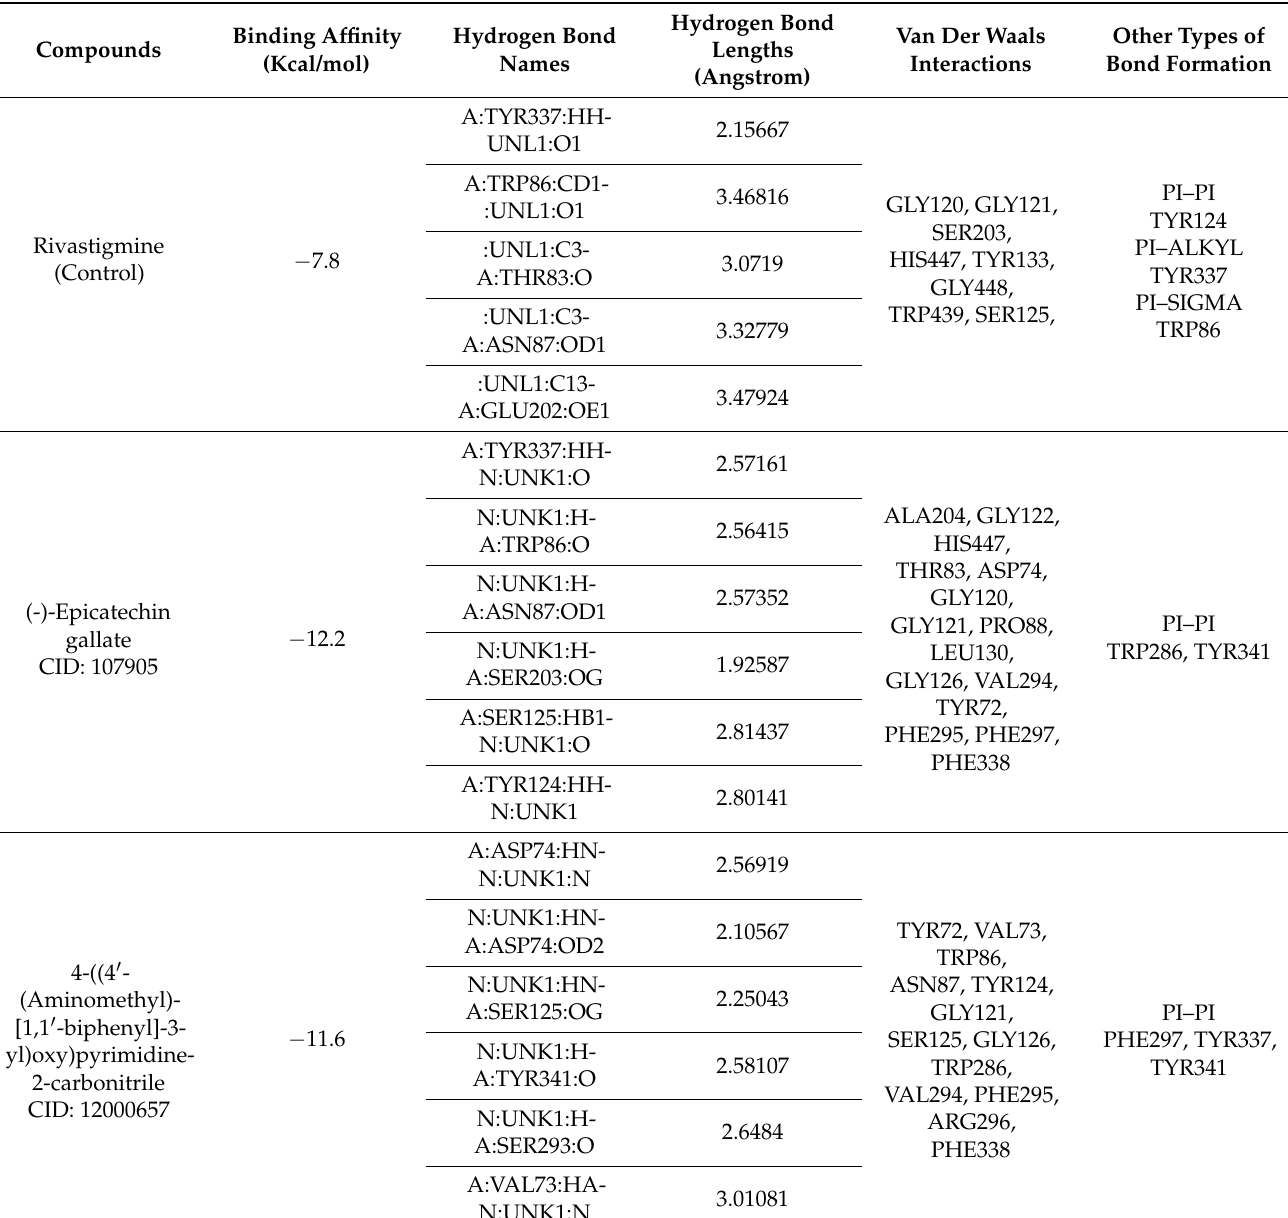
Table 1. Molecular docking data was obtained from the PyRx tool after performing molecular interactions between the selected natural compounds and AChE